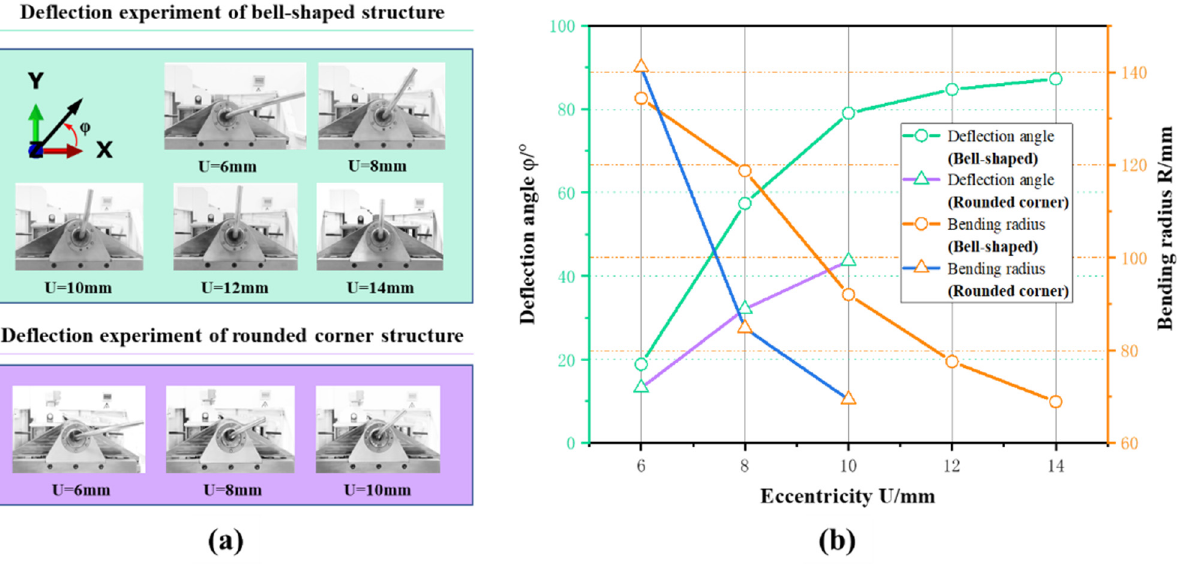
Figure 17. Goose-head height under different transition structures and eccentricities.